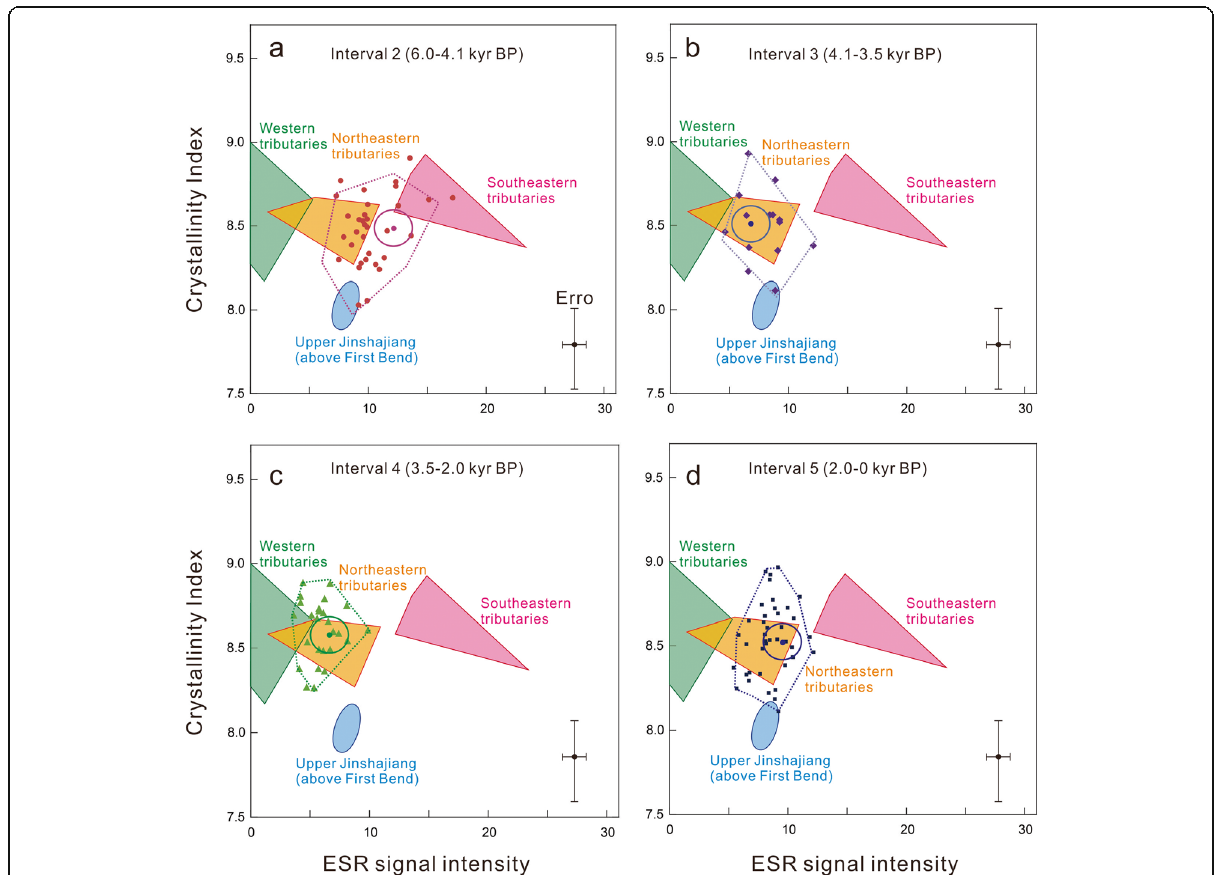
Fig. 5. a – d Comparison of the ESR signal intensity and CI of quartz in the fine silt fraction of MD06-3040 core sediments to those sediments from various parts of the modern Yangtze River drainage (Saito et al. 2017) for intervals 2 to 5 covering the last 6.0 kyr BP identified in this study. The circles represent the average values of the ESR signal intensity and CI of quartz during each individual